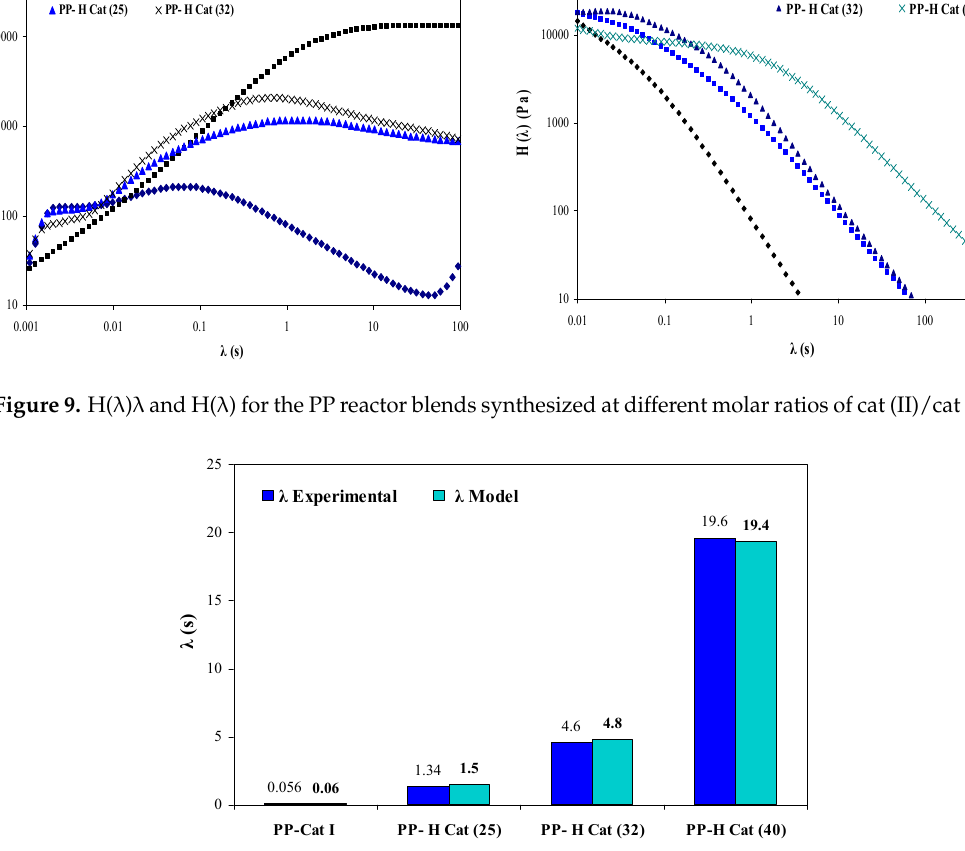
Figure 10. Relaxation time values for the PP reactor blends synthesized at different molar ratios of cat (II)/cat (I).